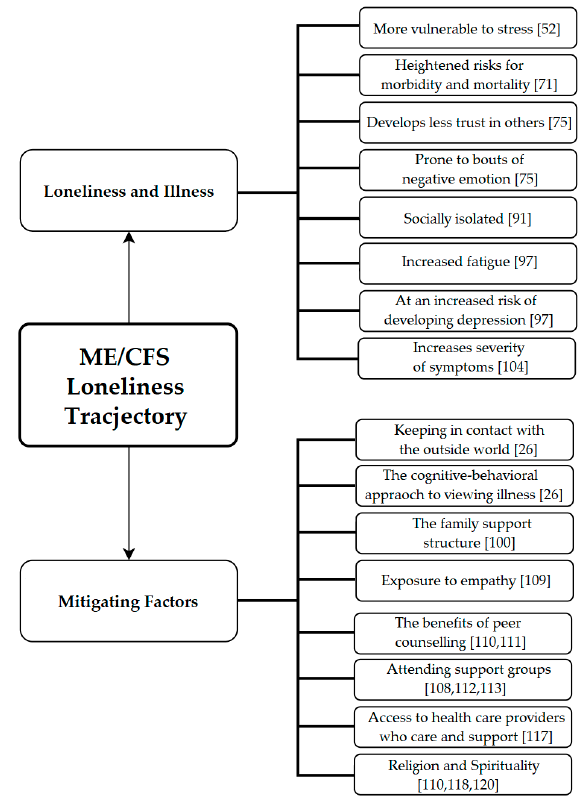
Figure 1. The interaction between ME/CFS and loneliness. [26,52,71,75,91,97,100,104,109– Figure1. TheinteractionbetweenME / 113,117,118,120].